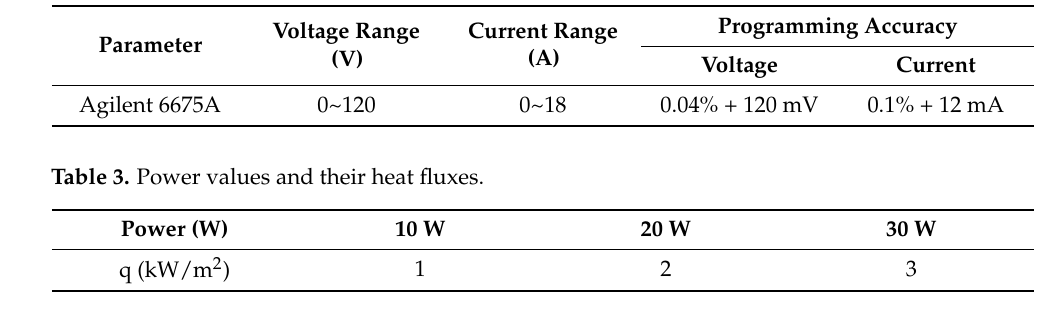
Figure 3. Power supply (Agilent 6675A). Table 2. Technical specification of power supply.